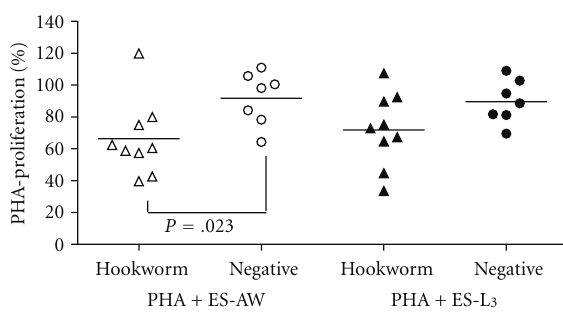
Figure 1: Inhibition of mitogen-stimulated PBMC proliferation after costimulationwith adult wormES (ES-AW, open symbols)and third-stage larval ES (ES-L 3 , full symbols) antigen in hookworm- infected ( ; n = 9) and egg-negative ( • ; n = 7) individuals. Sym- (cid:0) bols show individual percentages of proliferation in comparison with PHA-stimulated cultures only, and horizontal bars indicate mean values for each group. Significant di ff erences between groups are